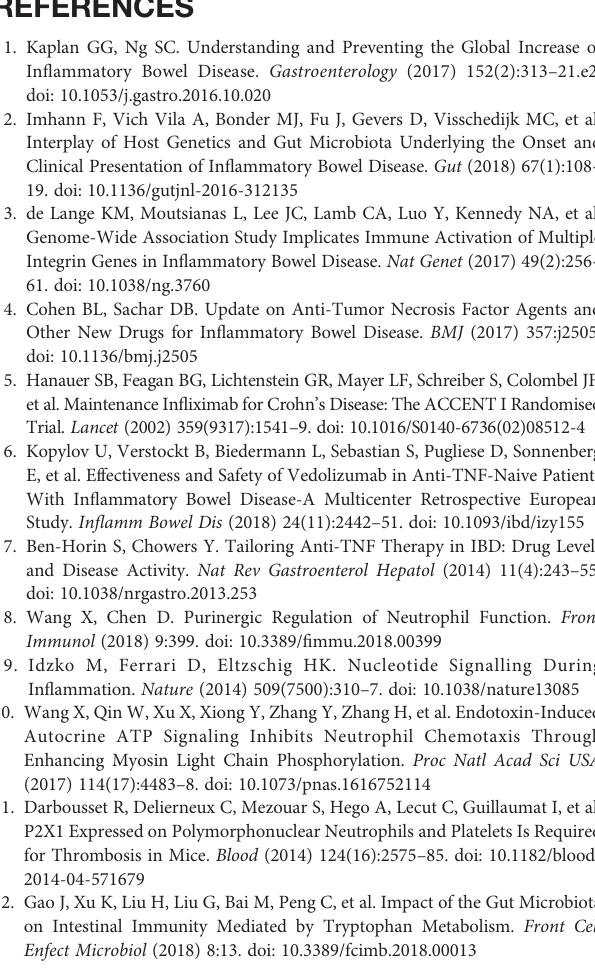
F4/80 was used to label macrophages. In fi ltrated neutrophils and macrophages and P2RX1 expression in each cell type were determined at D0 and D7. Supplementary Figure 4 | Composition of intestinal microbiota species in DSS- exposed WT and P2rx1 − / − mice. WT and P2rx1 − / − mice were treated with 2% DSS for 7 days. At days 0, 7, and 12, fecal microbiota was quanti fi ed using 16S rDNA sequencing. Detailed composition of intestinal microbiota species in each group was shown (n = 6 for D0 WT and P2rx1 − / − groups, n = 3 for the rest groups). Supplementary Figure 5 | Composition of intestinal microbiota species in DSS- exposed WT and P2rx1 − / − mice. WT and P2rx1 − / − mice were treated with 2% DSS for 7 days. At day 7, fecal microbiota was quanti fi ed using 16S rDNA sequencing. Detailed composition of intestinal microbiota species in each group was shown (n = 3 for each group). Supplementary Figure 6 | Expression of AhR target genes in DSS-exposed WT and P2rx1 − / − mice. WT and P2rx1 − / − mice were treated with 2% DSS for 7 days. At day 7, colon tissues were harvested and two AhR target genes, CYP1A1 and CYP1B1 , were detected by RT-qPCR (n = 4 per group). Supplementary Figure 7 | Genotyping results of WT and P2rx1-/- mice. PCR was performed for genotyping gene-edited mice. As shown in the representative image, No. 370, 374 and 378 were WT mice, whereas No. 372 and 376 were P2rx1-/- mice. Heterozygous parent (P), C57BL/6 (B6) and null (N) were set as controls. The rest are heterozygous